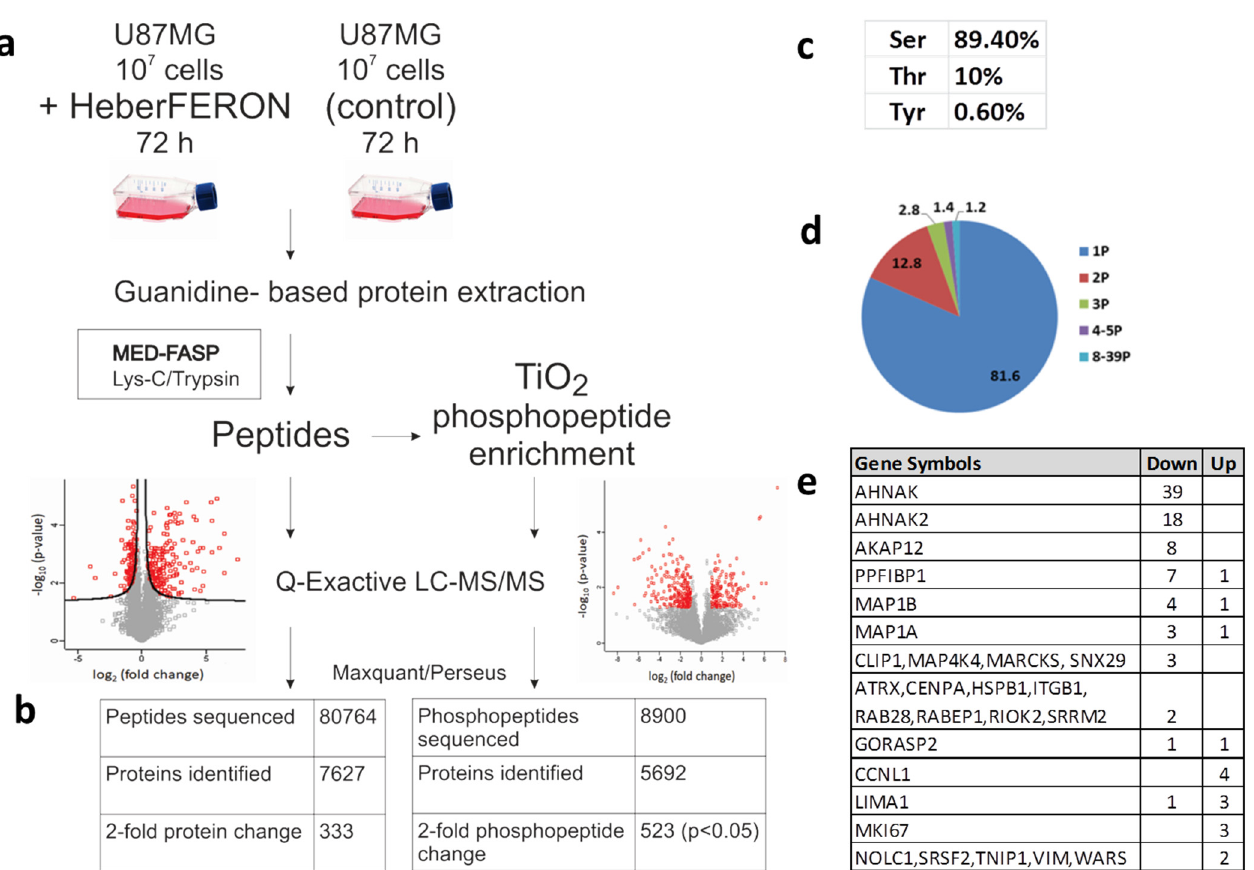
Figure 1. Experimental workflow and data processing for the identification of non-phospho-peptides and phospho-peptides regulated by HeberFERON. ( a ) Experimental workflow for sample processing, MS and data analysis ( b ) Comparison of identified non-phospho-peptides, phospho-peptides and proteins ( c ) Distribution of phosphorylated amino acids in % ( d ) Number of phosphorylation sites per protein represented in a pie diagram as % ( e ) Proteins with 2 or more different phosphosites changing phosphorylation. Up and Down represent the increment or decrement of the phosphorylation after HeberFERON treatment in the untreated control. Gene symbols are repre- sented.